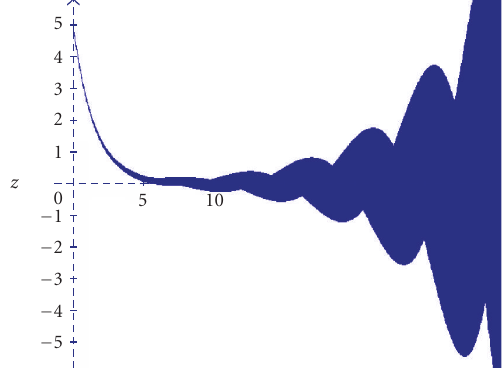
Figure 6.12 . Unstable solution of (5.2) in the point L 2 (87,85), a 0 = 5.